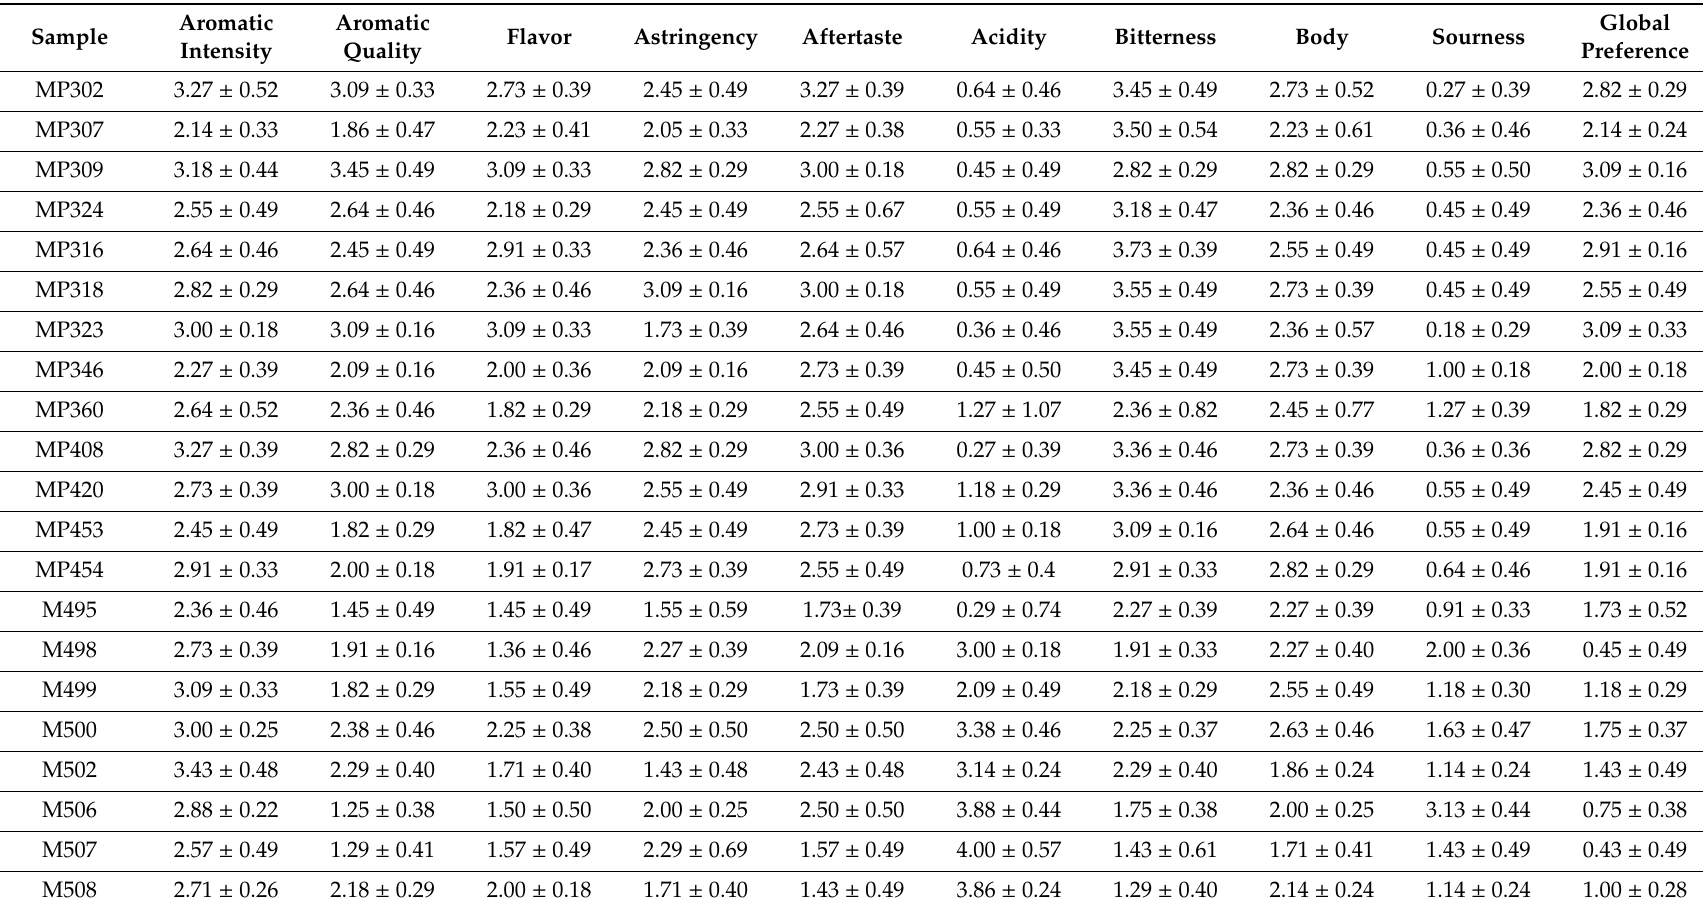
The values represent the average value with the standard deviation of 11 trained